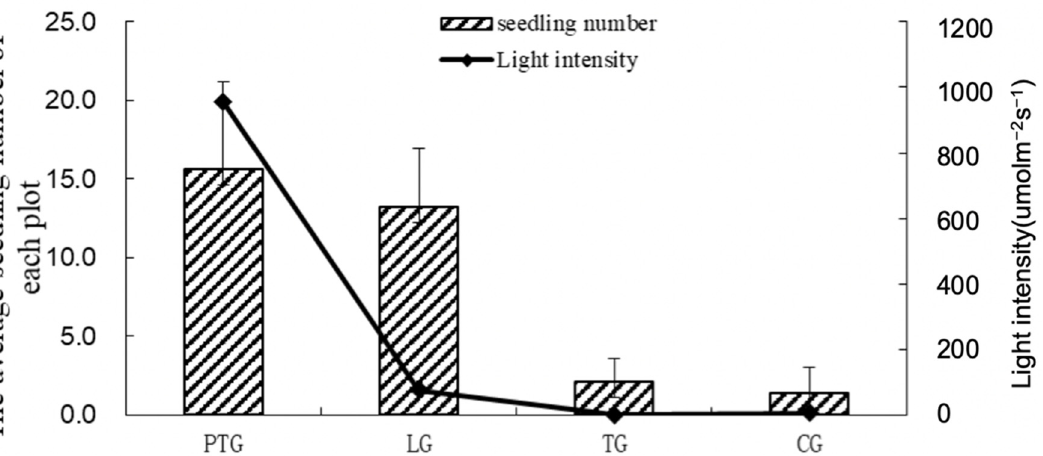
Figure 5. Effect of light intensity on the number of emerged seedlings in the soil seed bank under different photo-thermal treatments.